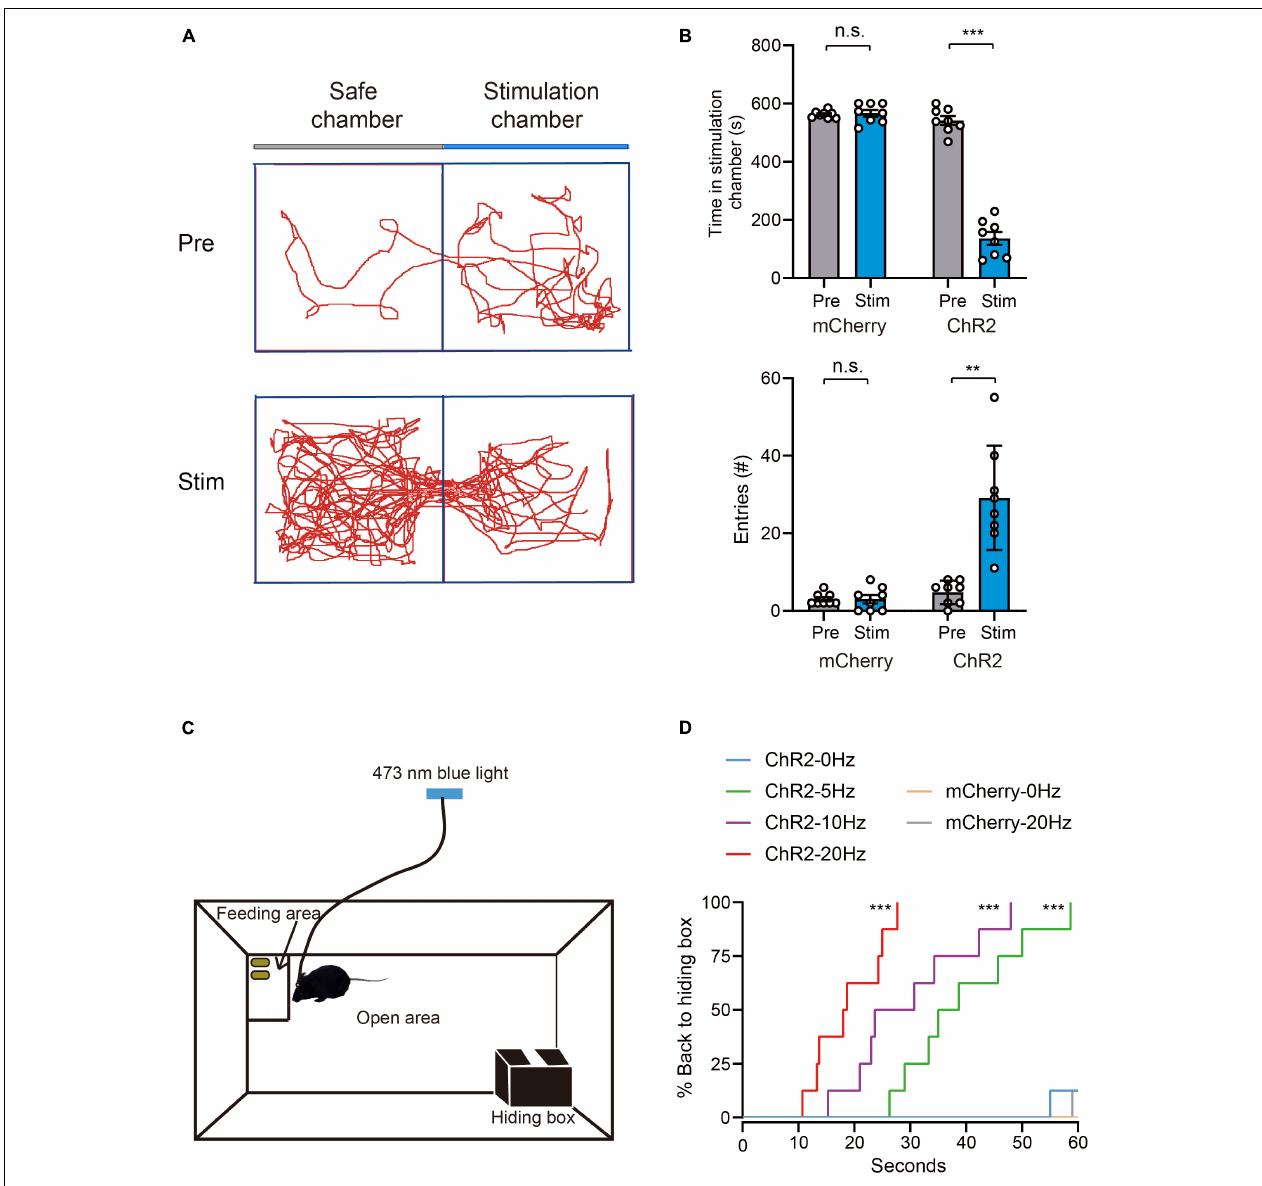
FIGURE 3 | Photoactivation of VTA glutamatergic neurons promotes avoidance and hiding behavior. (A) Example trajectories of mice in RTPP tests. (B) Photostimulation of VTA glutamatergic neurons affected the time spent in the stimulation chamber and safe chamber entries of mice in the RTPP experiment [ n = 8 ChR2 vs. n = 8 mCherry; two-way repeated-measures ANOVA, virus × stimulation, F (1,14) = 196.1, P < 0.001; F (1,14) = 27.82, P = 0.0001, Bonferroni post hoc comparison]. (C) Schematic of hiding box experiment. (D) Real-time probability of hiding upon stimulating glutamatergic VTA ( n = 8 ChR2, n = 8 mCherry; Kaplan–Meier5 survival analysis with Bonferroni’s multiple comparison; Log rank = 80.77, P < 0.001, mCherry: 20 Hz-sham, P = 0.32; ChR2: 5 Hz-sham, P < 0.001; 10 Hz-sham, P < 0.001; 20 Hz-sham, P < 0.001). Data are represented as the mean ± SEM. ** P < 0.01, *** P < 0.001, n.s., not significant.